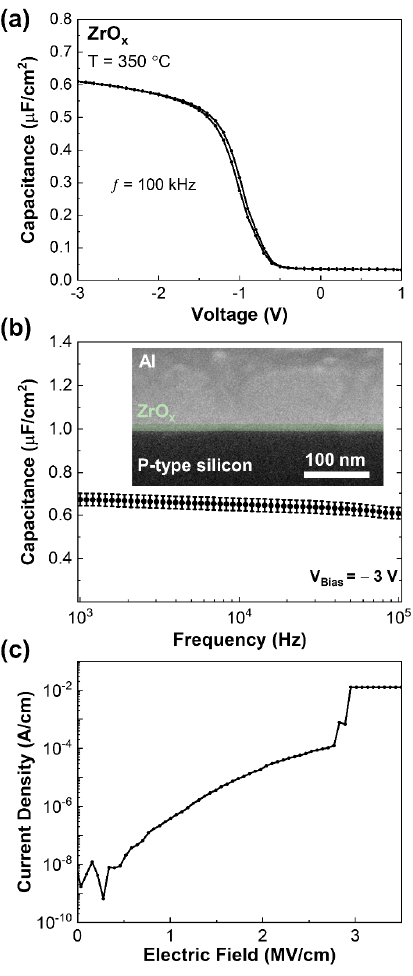
Figure 11. Electrical characteristics of solution-based ZrO x MIS capacitors produced at 350 °C: ( a ) typical capacitance-voltage characteristics at 100 kHz; ( b ) average of capacitance versus frequency characteristics, and the inset shows the cross-section SEM of the devices; ( c ) typical leakage current density versus the breakdown field. Figure 11c shows a typical current density versus breakdown field dependence. The results are in accordance with solution-based ZrO x thin film capacitors [71]. Once low leakage current density was reached (<10 − 5 A/cm 2 ), it opens the window for future appli- cations such as gate insulators for solution-based thin film transistors.